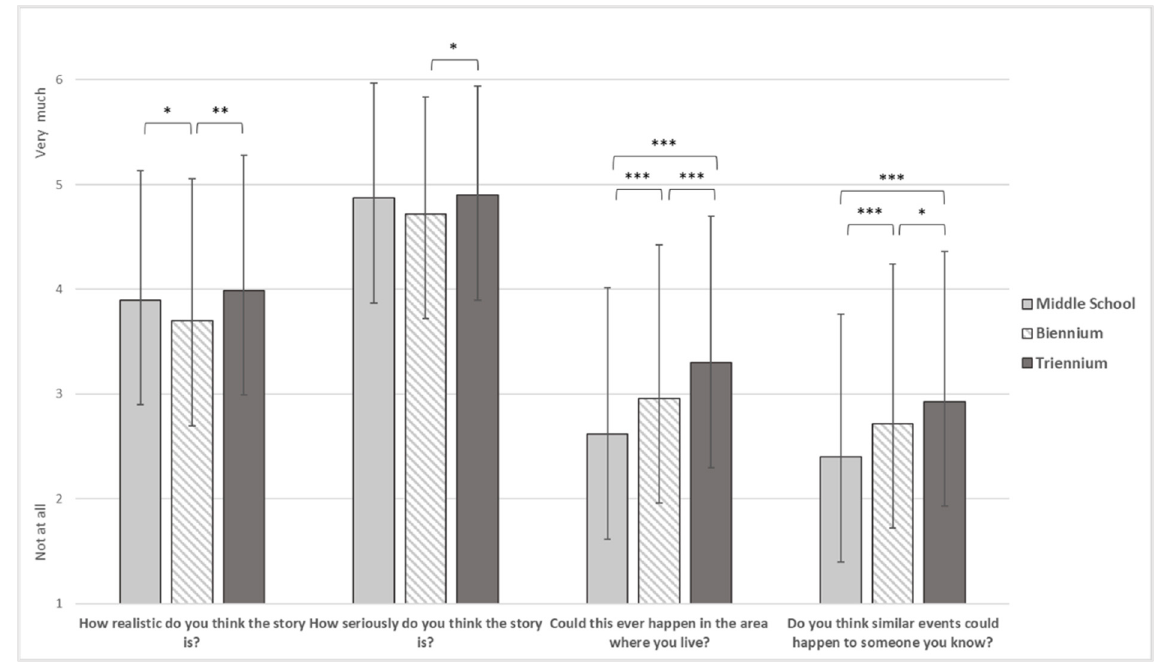
Figure 1. Event’s Features. Note. * = p < 0.05, ** = p < 0.01, *** = p < 0.001.